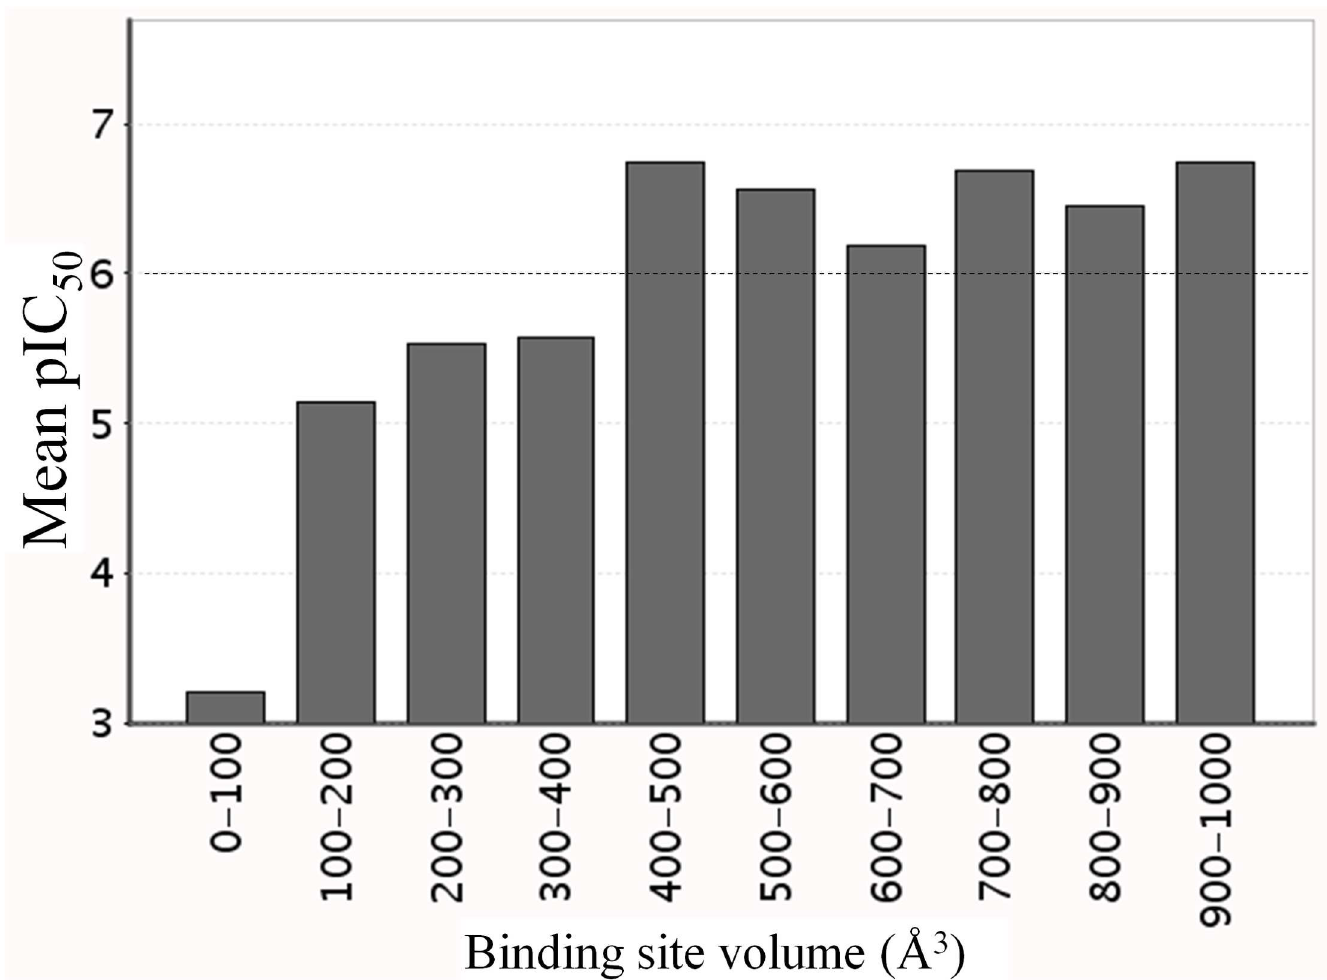
Fig 7. Histogram correlating the volume of inhibitor’s binding site versus pIC 50 , generated using ca. 3000inhibitor/target complex structures with known IC 50 s from PDBbind data base. Dashedline represents the thresholdbetweenmicromolarand nanomolar order inhibitor.